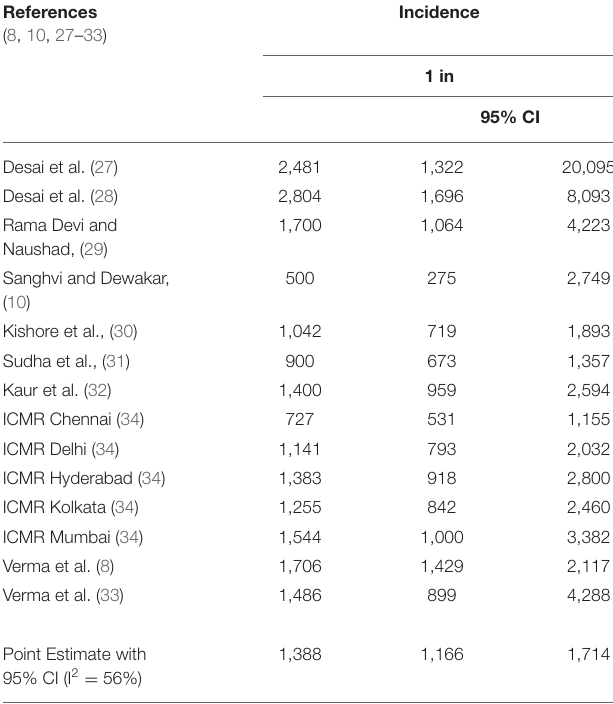
TABLE 2 | Pooled estimate for incidence of hypothyroidism in India.